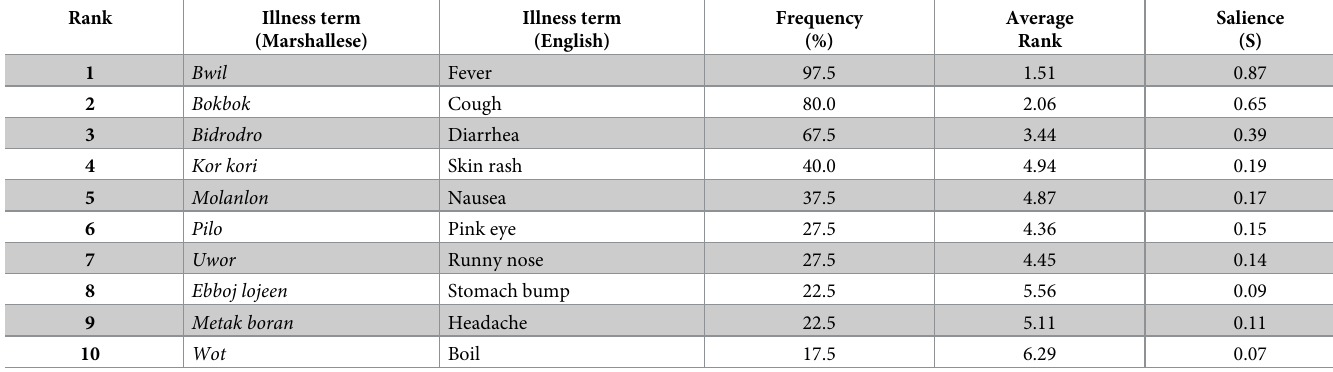
Table 5. Salient infant and young child illnesses in Arno